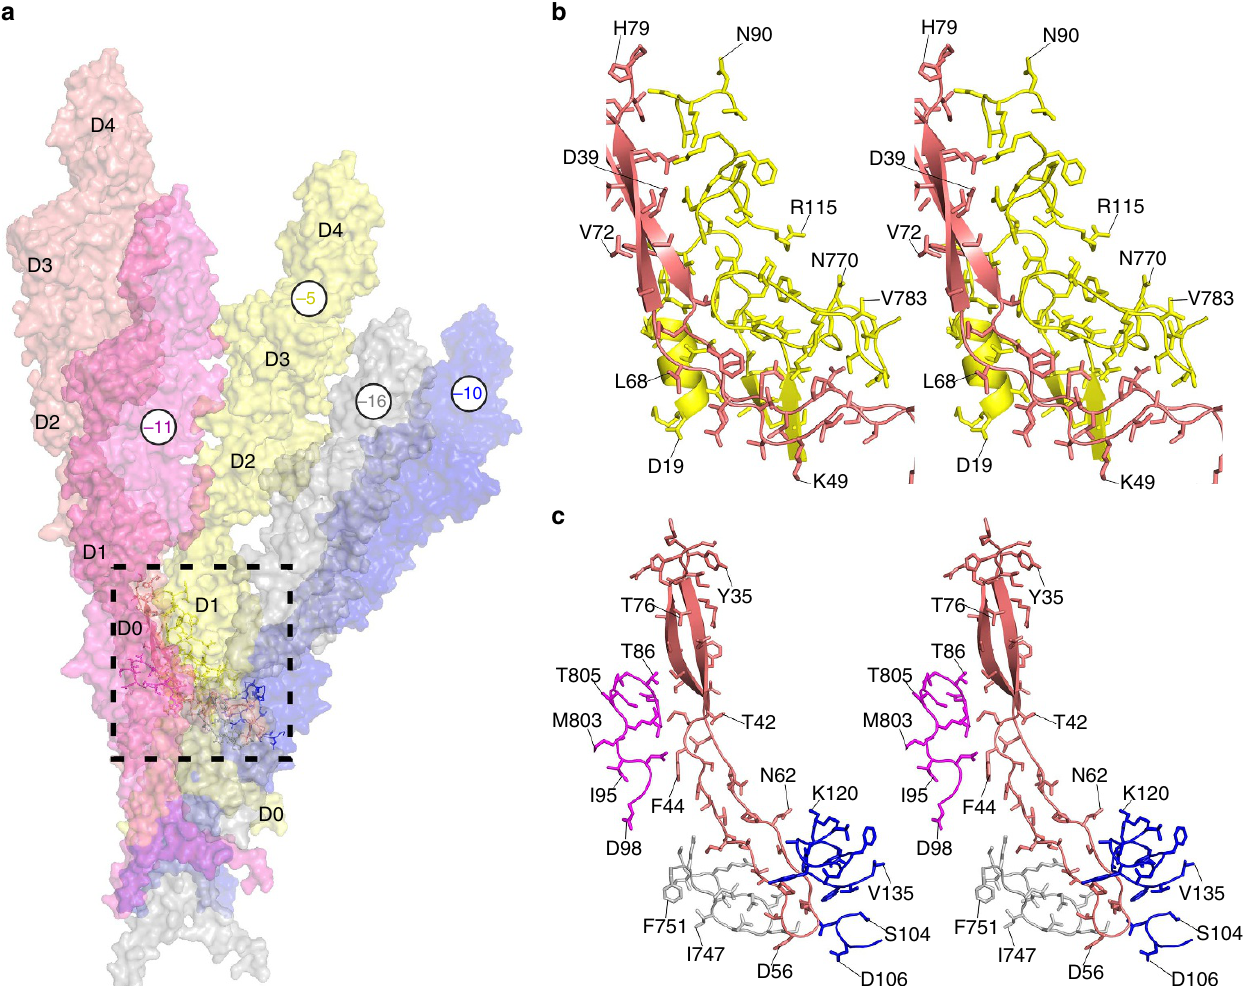
Figure 5 | Global interactions of the L -stretch. The L -stretch has extensive contacts with segments located in domain D1. ( a ) Overview of FlgE molecules that interact with the L -stretch motif through segments of their D1 domain. ( b ) A blown-up stereo view showing part of domain D1 (in yellow) of the FlgE (in position –5) that enlaces the L -stretch. ( c ) A blown-up stereo view showing segments of D1 domains of molecules at position –10 (blue) and –16 (grey), which interact with the tip of the L -stretch, and at position –11 (magenta) that interacts with the middle part of the L -stretch. The circled numbers indicate the order of appearance of each FlgE molecule during the building of the hook. Figure prepared with